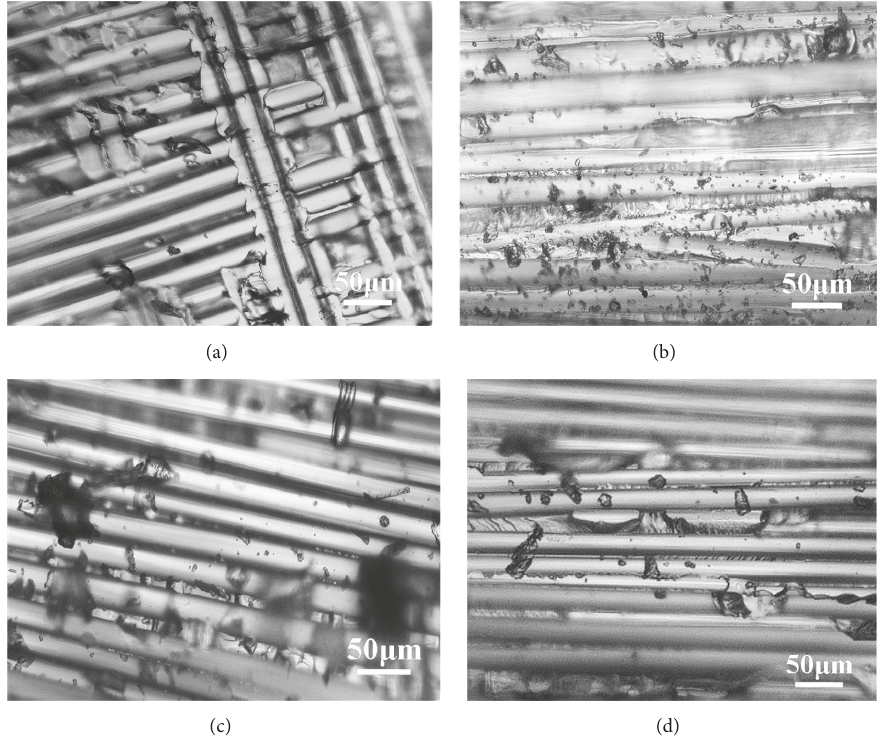
Figure 5: Micrographs of the longitudinal section ( × 50) of the unstressed specimens: (a) unconditioned specimen; (b) WWD0 after 60WD cycles; (c) SWD0 after 60 WD cycles; and (d) WWD0 after 180WD